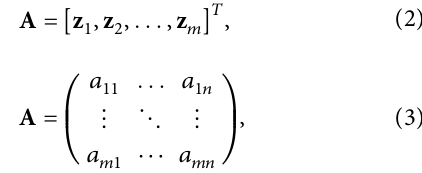
Figure 6: Frequency distribution of the vibration signal of outer ring fault under the same load and different